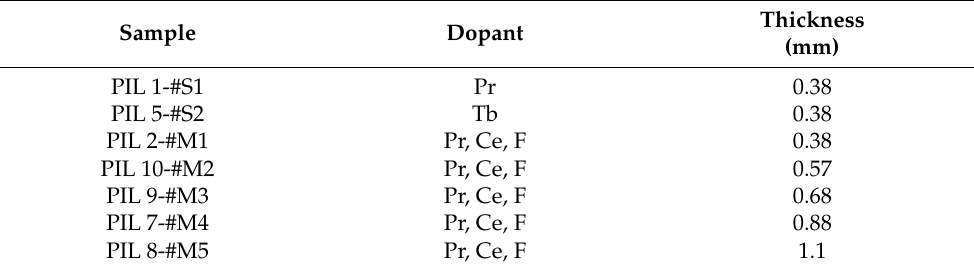
Table 1. List of samples in the form of pills produced with different dopants and thicknesses. Sample